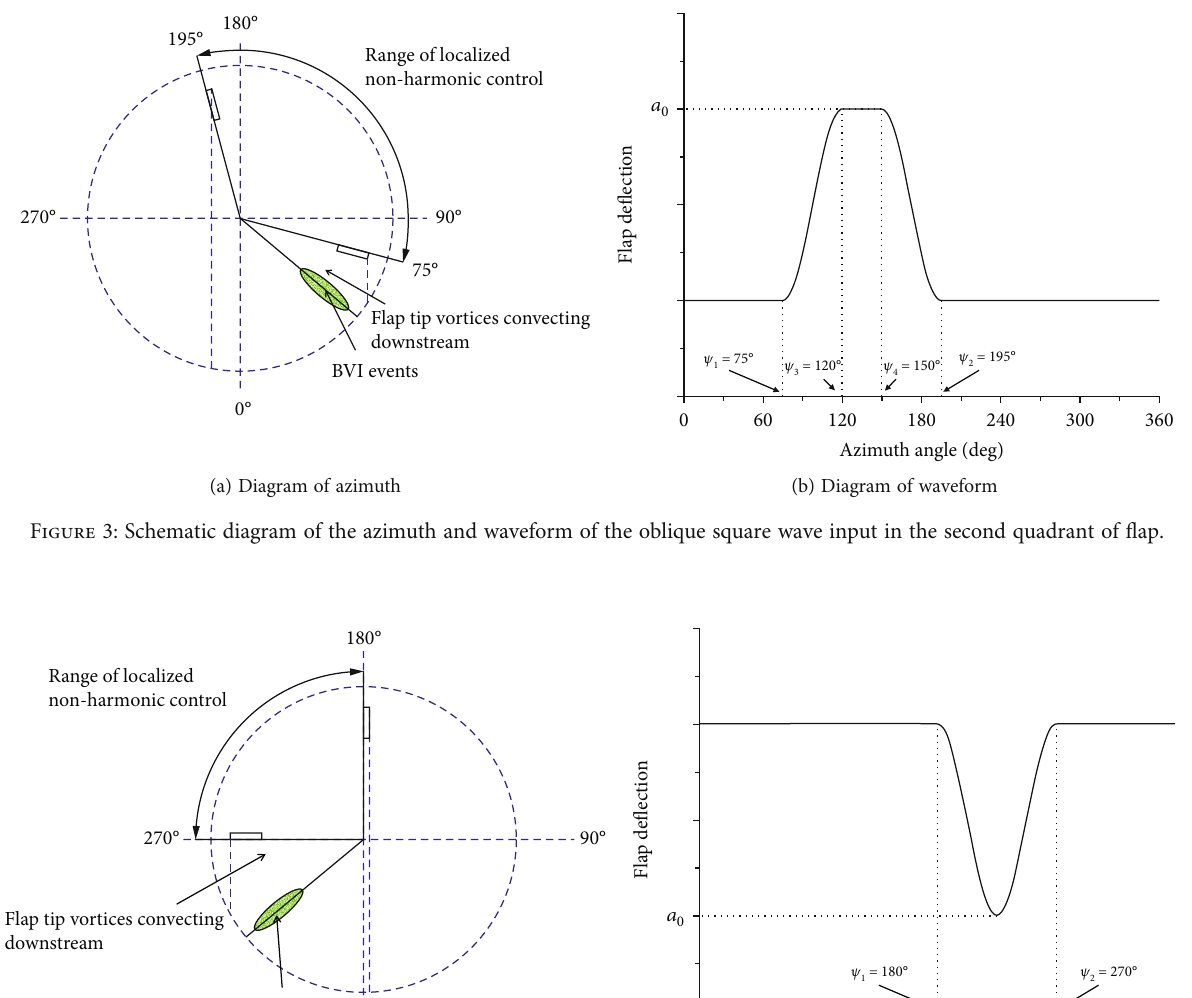
Figure 4: Schematic diagram of the azimuth and waveform of the cosine input in the third quadrant of the fl